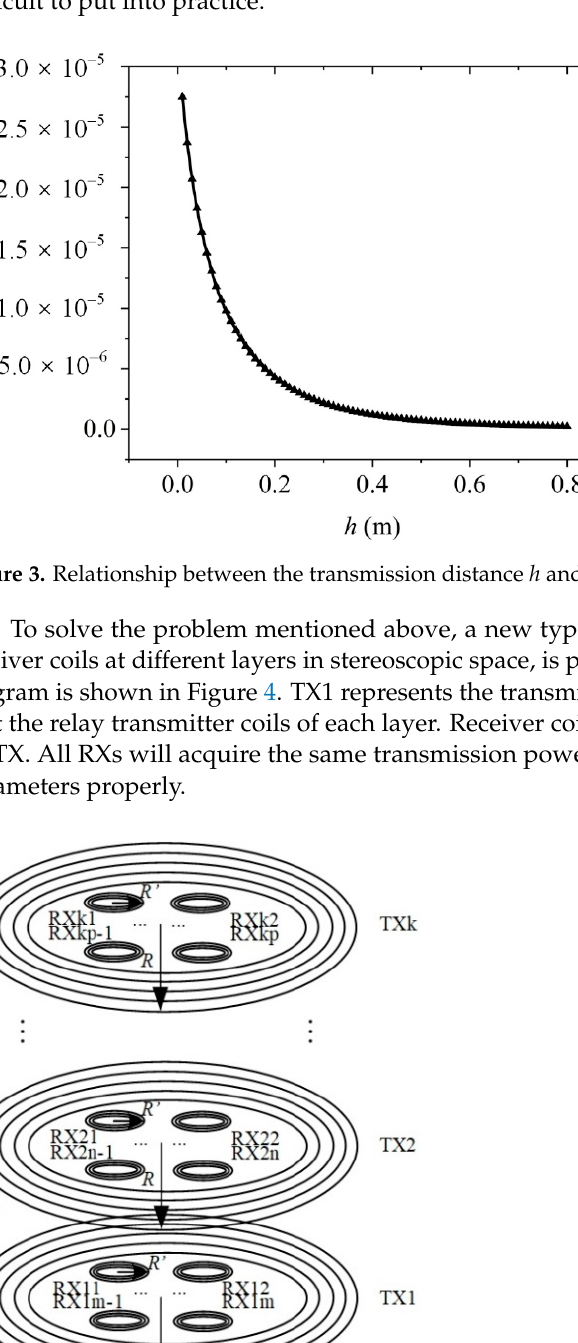
Figure 4. The structure of the proposed WPT system.